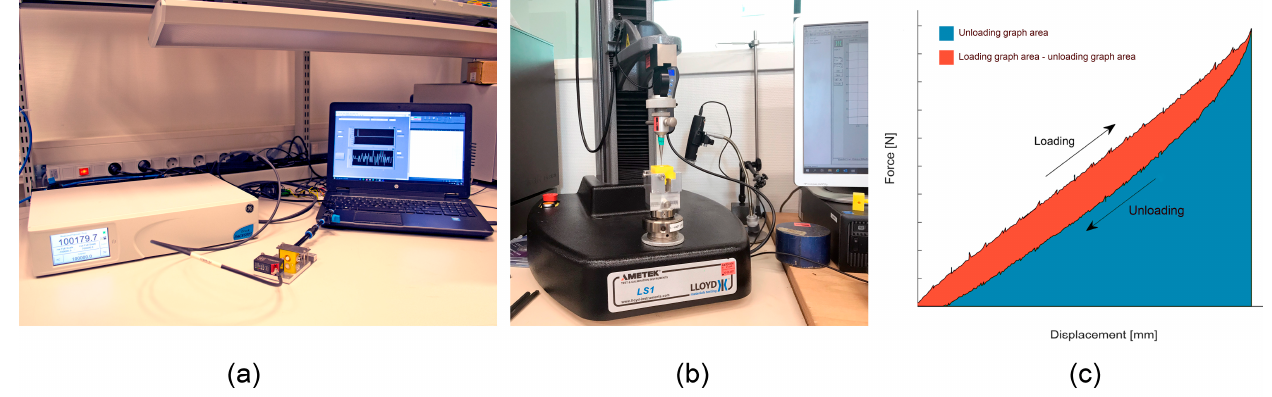
Figure 8. Set-ups used in the experimental evaluation. ( a ) Set-up for the forward cutting force test and cutting speed test. ( b ) Set-up for the backward cutting force test. ( c ) Example of a force displacement plot used to calculate the spring coefficients of the prototypes.